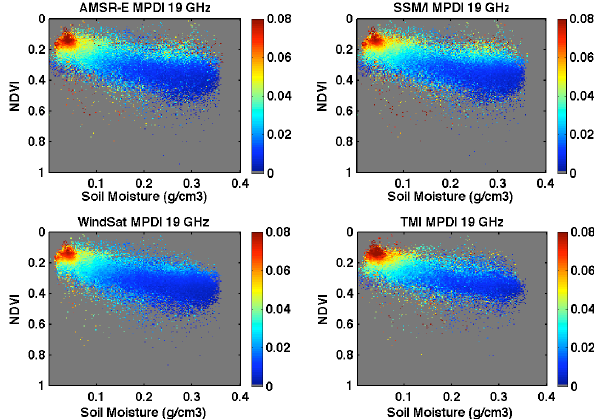
Figure 3. Emissivity MPDI values from various sensors/providers at different NDVI and soil moisture ranges at 19GHz for July